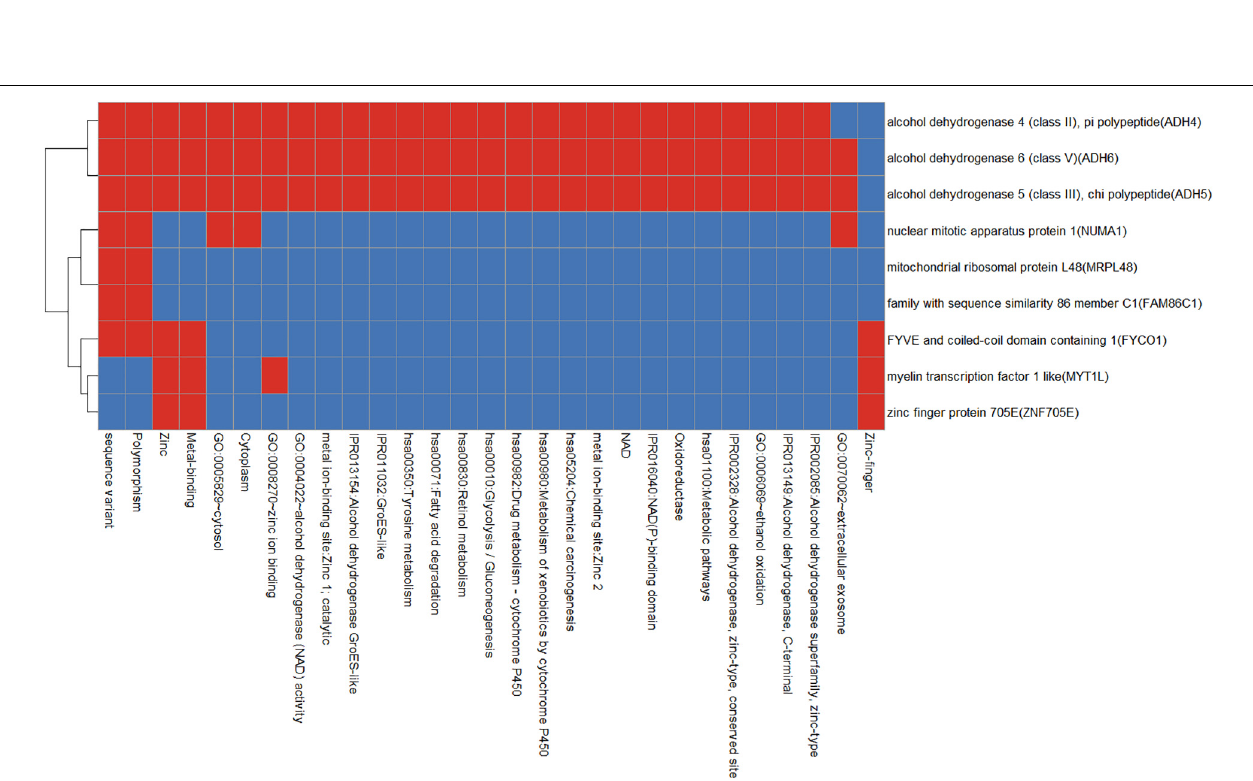
FIGURE 6 | Functional annotation heat map of gingivitis related genes. Red means corresponding gene-term association positively reported and blue means corresponding gene-term association not reported yet.